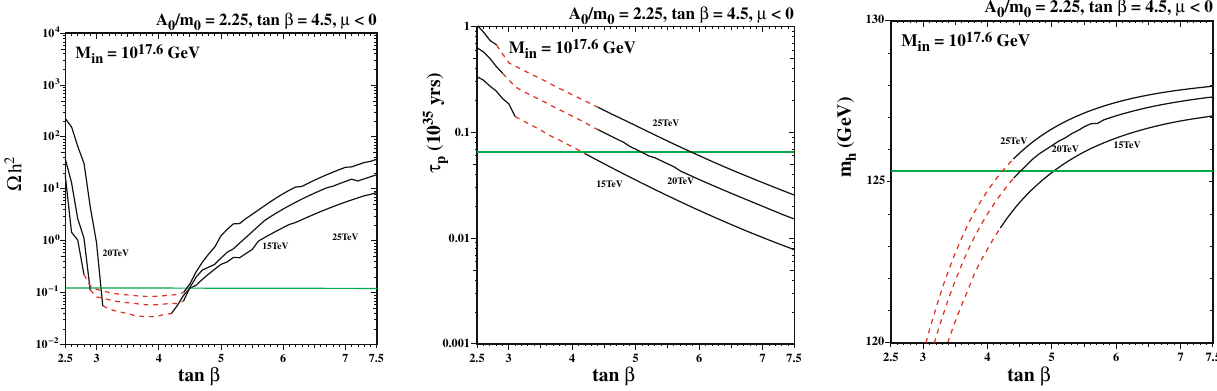
Fig. 8 As in Fig. 6, as functions of tan β for the indicated fixed values of m 1 / 2 ∈ [ 15 , 25 ] TeV and m 0 chosen to obtain the cosmological value of (cid:21) 2 for tan β = 4 . 5 with the same values of the other input parameters as in Fig. LSP h